Question: Generate an informative caption for the figure above.
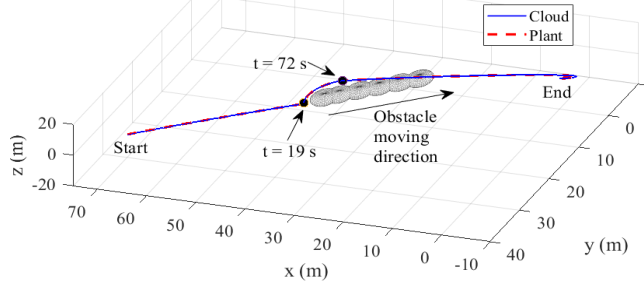
Answer: Comparison of obtained trajectory in 3D space